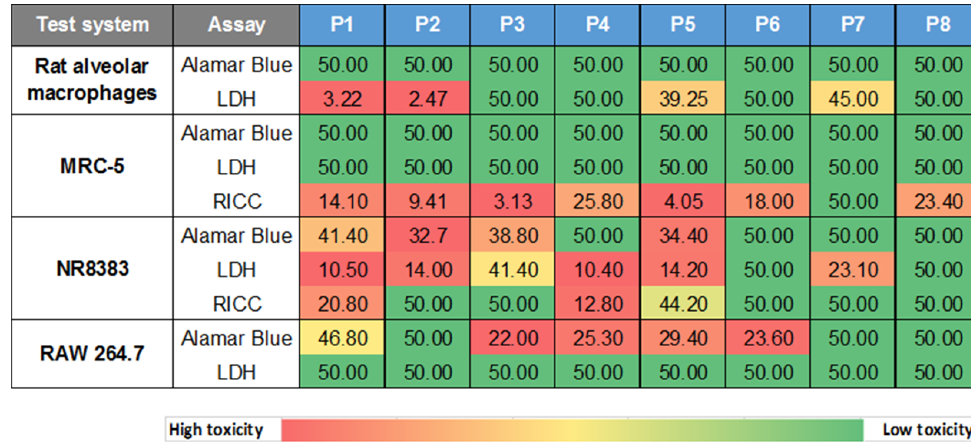
Figure 4. Heatmap of in vitro cytotoxicity screening results. The cytotoxic potential of GRNP was screened in primary rat alveolar macrophages (AM), human MRC-5 lung fibroblasts, the rat alveolar macrophage cell line NR8383 and the murine macrophage-like cell line RAW 264.7. Cells were incubated for 24 h with the various GRNP samples and membrane damage (LDH release), metabolic activity (AlamarBlue ® test) and cell proliferation (RICC; MRC-5 and NR8383 cells) were determined. Numbers given represent BMD30 values [µg/cm 2 ], calculated from three independent experiments with five concentrations (3.125, 6.25, 12.5, 25 and 50 µg/cm 2 ) each. A value of 50 is given where the final BMD30 value was calculated to be greater than 50 µg/cm 2 .